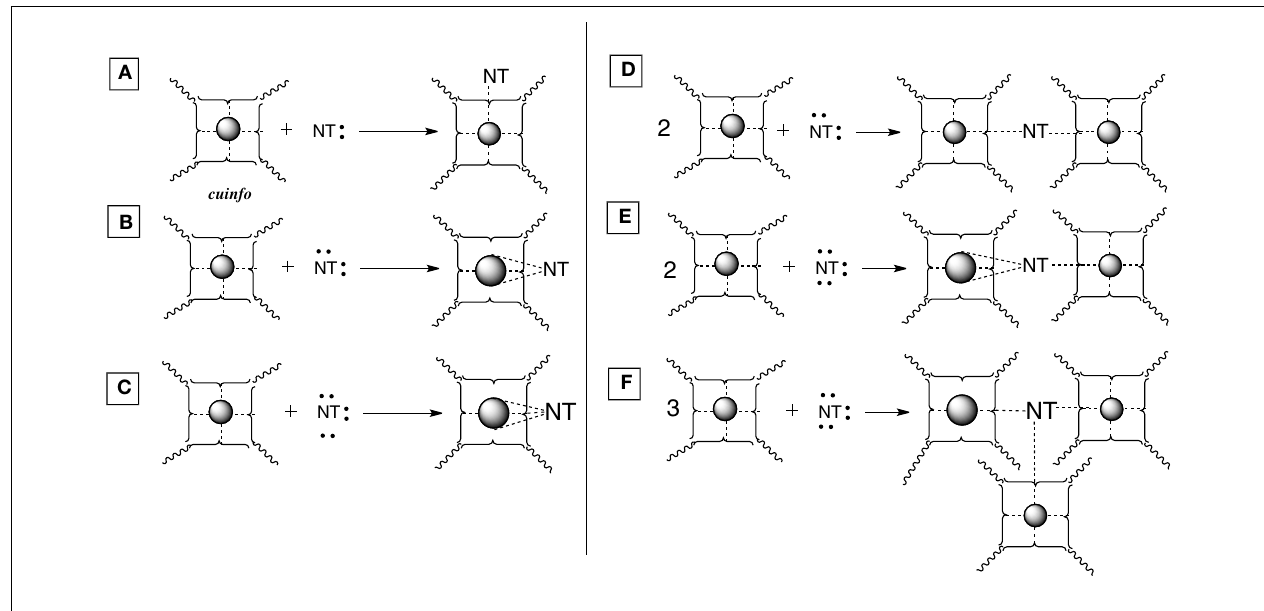
FIGURE 4 | Various types of [ cuinfo: NT] complexes. (A) A monodentate NT replaces one neutrix metal bond. (B) A bidentate NT couples (entangles) 2 cuinfo . (C) A tridentate NT replaces three neutrix metal bonds. (D) A